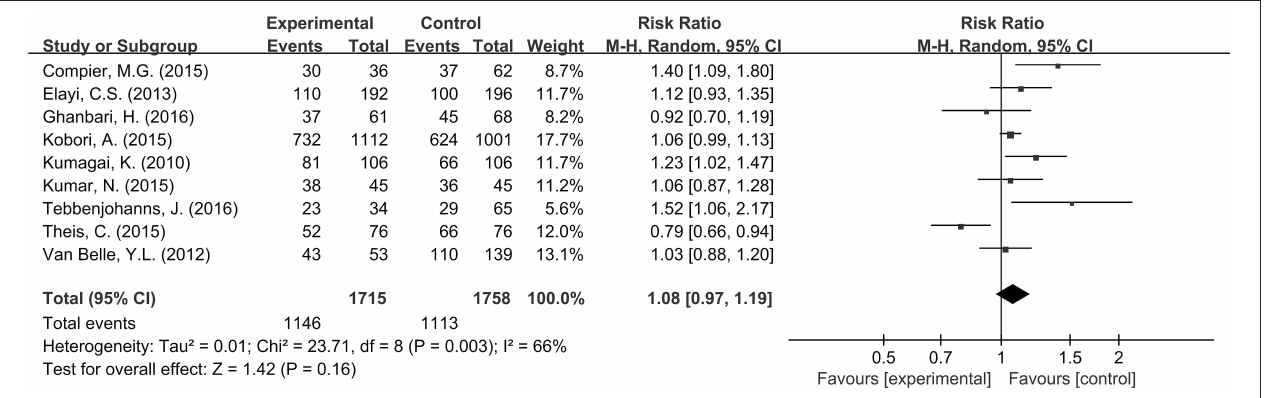
Frontiers in Physiology |